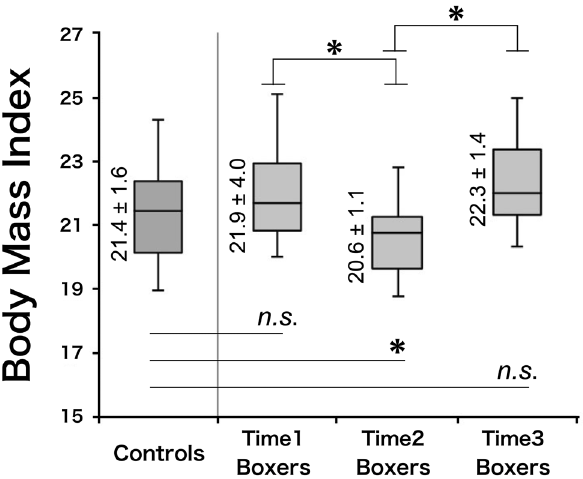
Figure 2. Body mass index of controls and boxers. The boxer BMI at Time2 was significantly decreased [ F (2, 59) = 10.21, p < 0.01] in repeated measures ANOVA. Bonferroni correction was used for the post-hoc analysis. BMI, body mass index; n.s. , not significant.